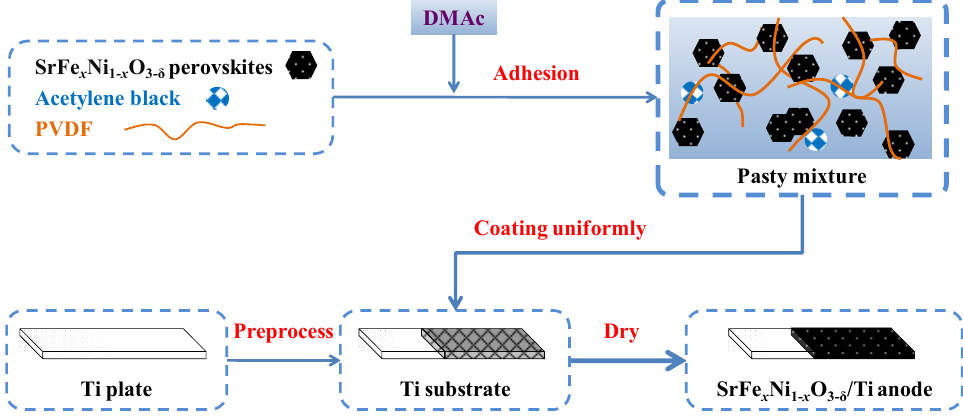
Table 1. Components of materials for preparing the SrFe x Ni 1− x O 3−δ /Ti anode.